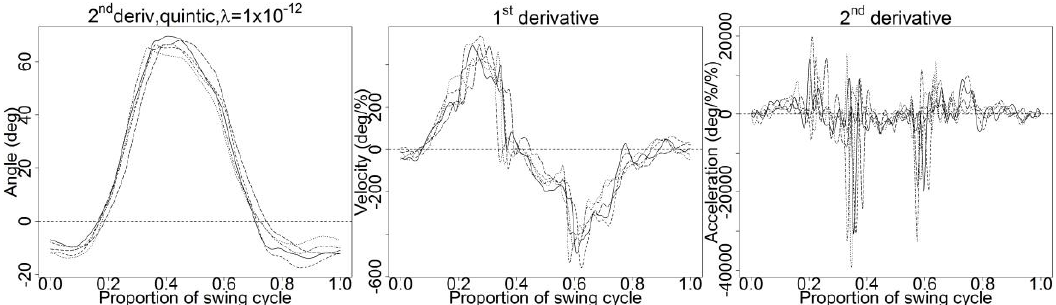
( d ) Figure A4. Smoothing using quintic spline basis with various values of and ( d )